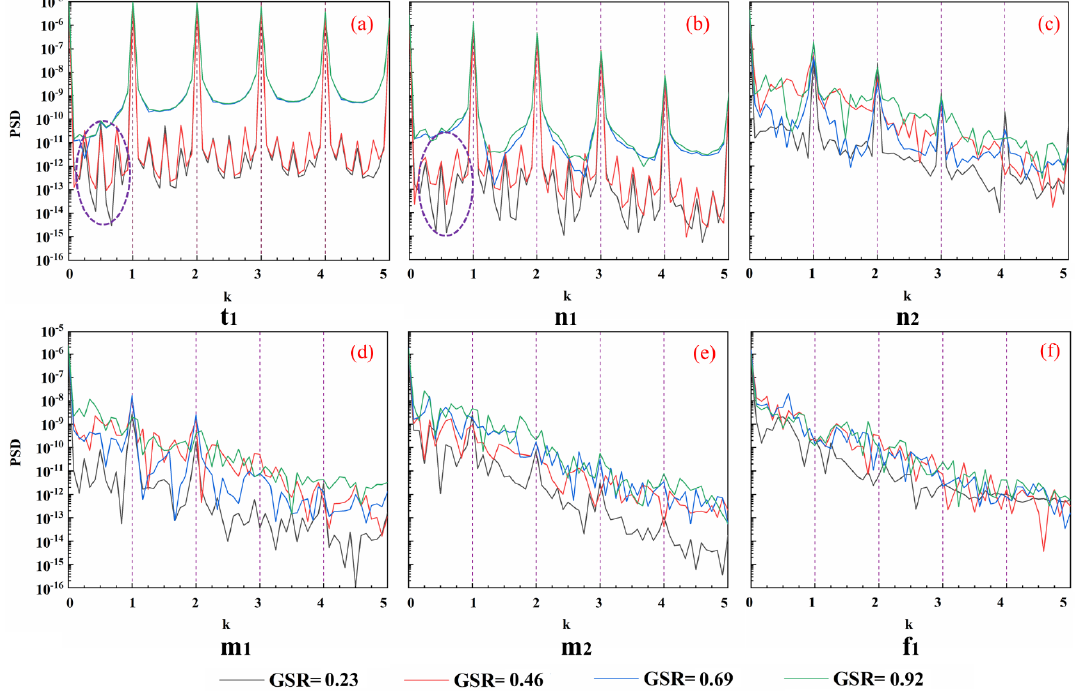
Figure 18. Diagram of power spectral density (PSD) at the measuring points: ( a ) The PSD distribution at t 1 measuring point; ( b ) The PSD distribution at n 1 measuring point; ( c ) The PSD distribution at n 2 measuring point; ( d ) The PSD distribution at m 1 measuring point; ( e ) The PSD distribution at m 2 measuring point; ( f ) The PSD distribution at f 1 measuring point.